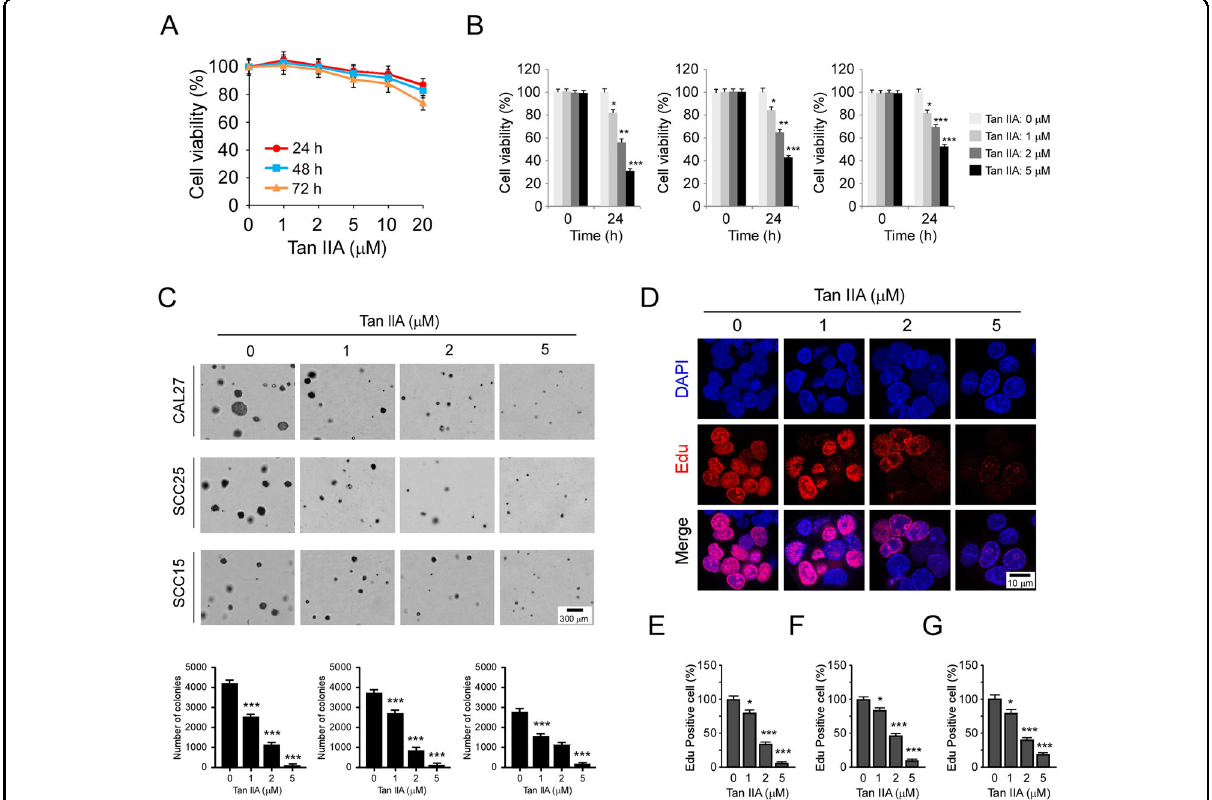
Fig. 3 Tan IIA suppresses OSCC cells. A MTS assay analyzes the cell viability of hTERT-OME cells with Tan IIA treatment for various time points. B MTS assay analyzes the cell viability of CAL27 (left), SCC25 (middle), and SCC15 (right) cells with Tan IIA treatment for 24 h; n = 3 independent biological replications, one-way ANOVA. C Soft agar assay examines the colony formation of CAL27 (top), SCC25 (middle), and SCC15 (bottom) cells treated with Tan IIA; n = 3 independent biological replications, one-way ANOVA; * p < 0.05, ** p < 0.01, *** p < 0.001. D – G Edu incorporation assay and quantitative analysis of the effect of Tan IIA on OSCC proliferation. ( D ) The representative image of Edu incorporation assay for CAL27 cells. ( E – G ) Quantitative analysis of Edu incorporated cells for CAL27 ( E ), SCC25 ( F ), and SCC15 ( G ); n = 3 independent biological replications, one-way ANOVA; * p < 0.05, ** p < 0.01, *** p <